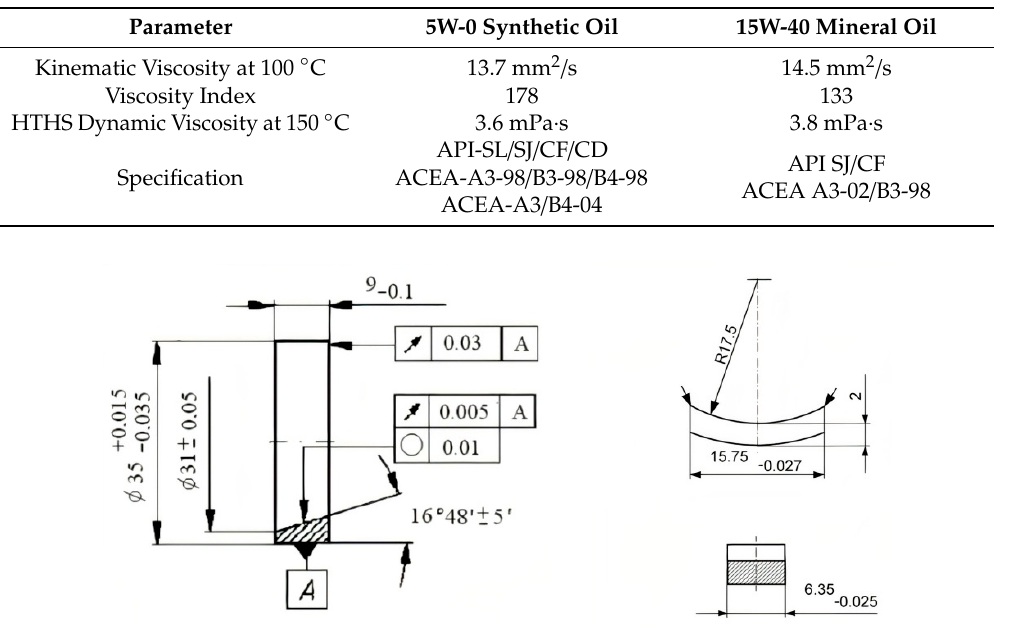
Figure 1. Dimensions of elements of the tested pair (mm).